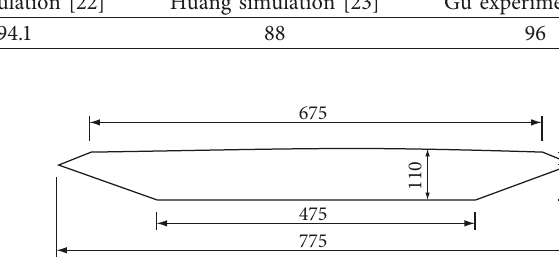
Figure 6: The size of the model in the forced vibration tests.